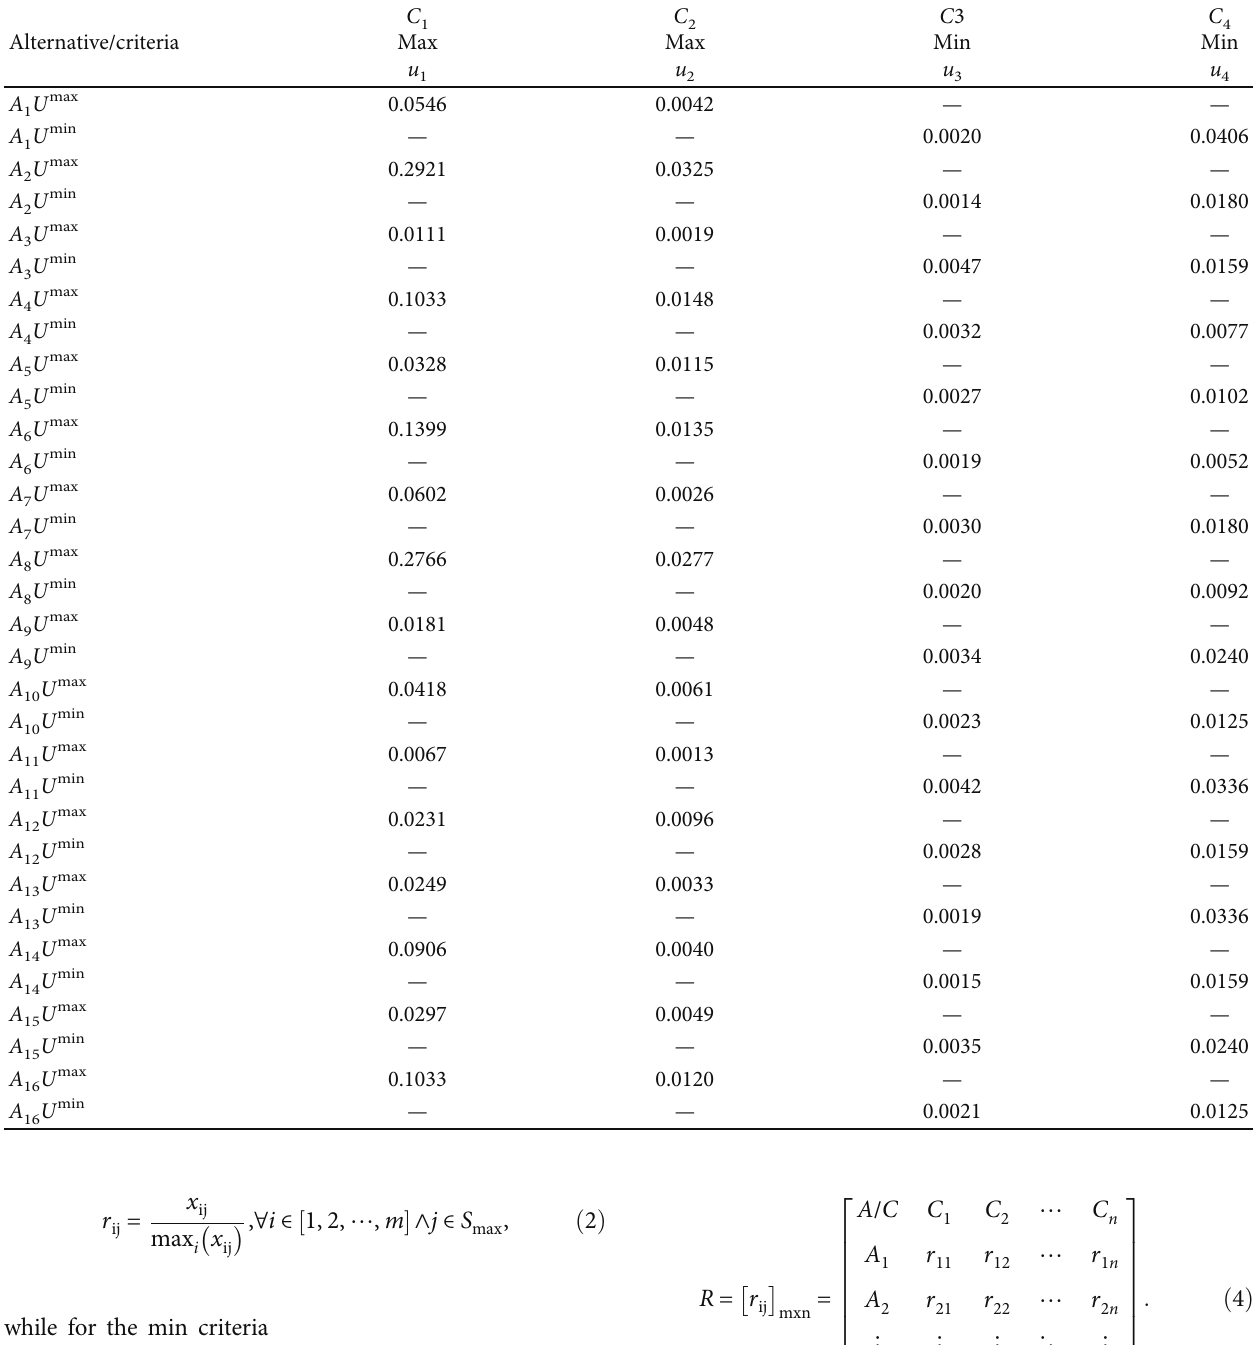
Table 5: Decomposition of